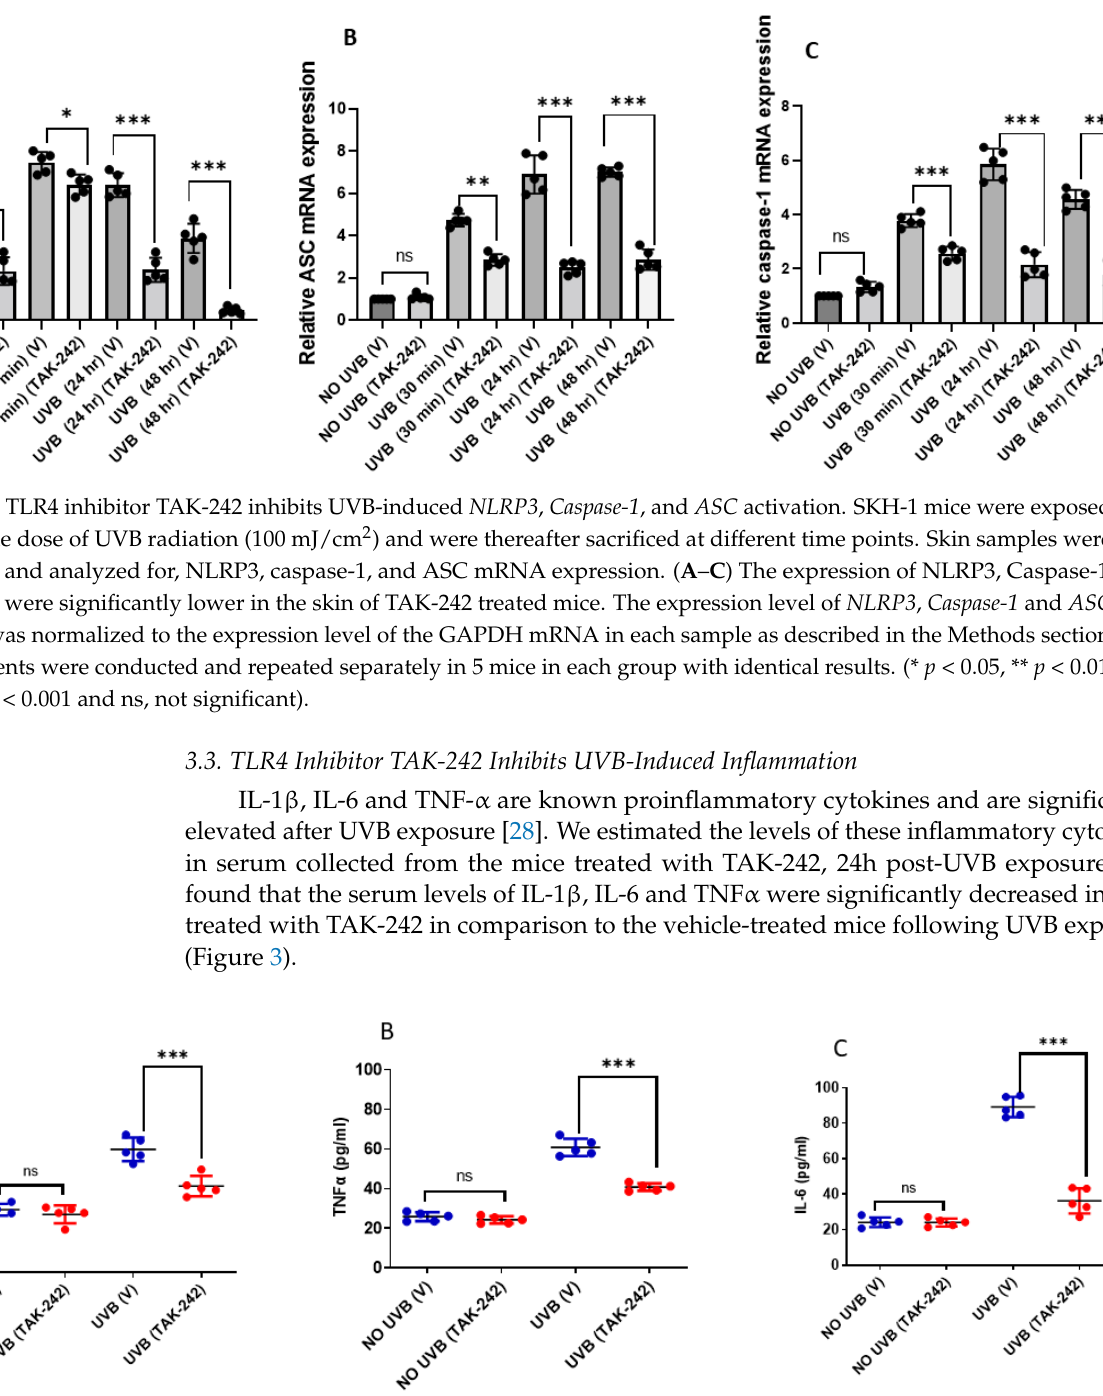
Figure 3. TLR4 inhibitor TAK-242 causes a decrease in expression of inflammatory cytokines. SKH-1 mice were exposed to a single dose of UVB radiation (100 mJ/cm 2 ) and were thereafter sacrificed after 24 h to collect blood. Serum was collected from blood and concentrations of IL-1 β , TNF- α and IL-6 were determined using Invitrogen (Thermofisher Scientific, Waltham, MA, USA) enzyme-linked immunosorbent assay (ELISA) kits according to the manufacturer’s instructions. ( A – C ) The levels of IL-1 β , TNF- α and IL-6 were significantly reduced in serum, following treatment with TAK-242 followed by UVB exposure. The data represents mean ± SD from five mice. (*** p < 0.001 and ns, not significant).